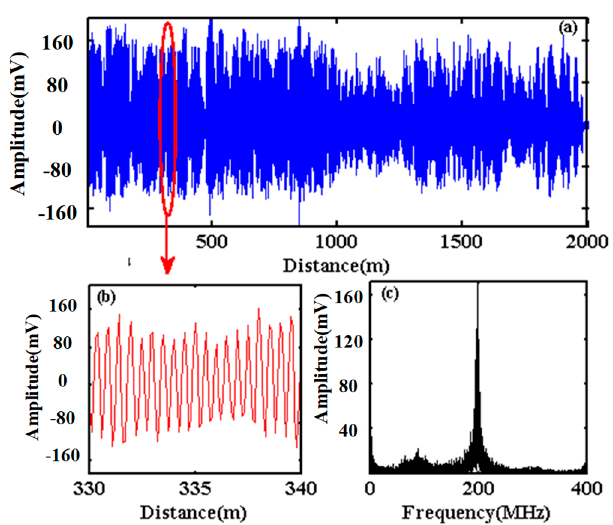
Figure 7. ( a ) Original coherence curve, ( b ) partial enlargement and ( c ) frequency spectrum of original coherence curve.